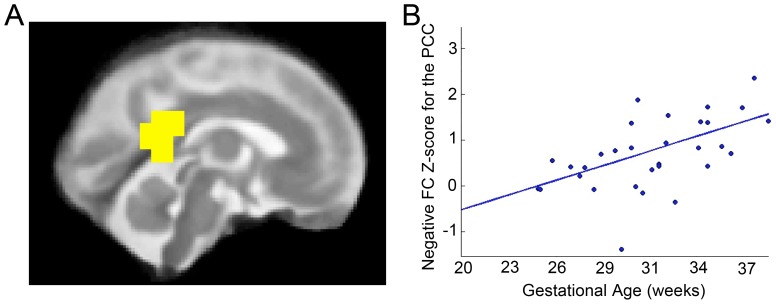
Negative connectivity in the posterior cingulate cortex (PCC).With advancing gestational age, intramodular anticorrelations of the PCC (in yellow, A) significantly increase (B), p<.05, FDR corrected. The PCC thus becomes more anticorrelated with other brain modules as fetuses mature.